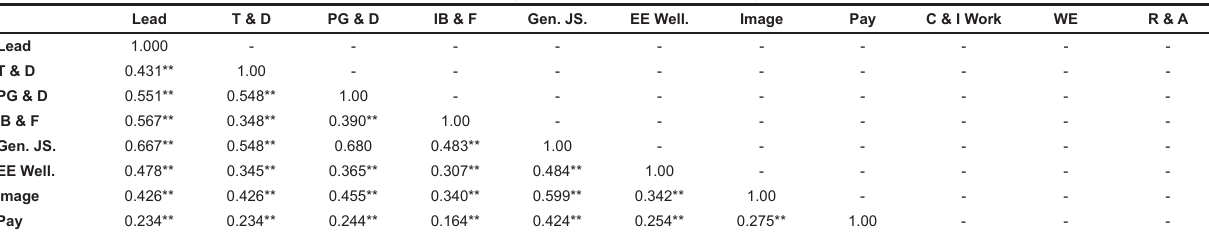
Table 6 Correlation between organisational climate dimensions and job